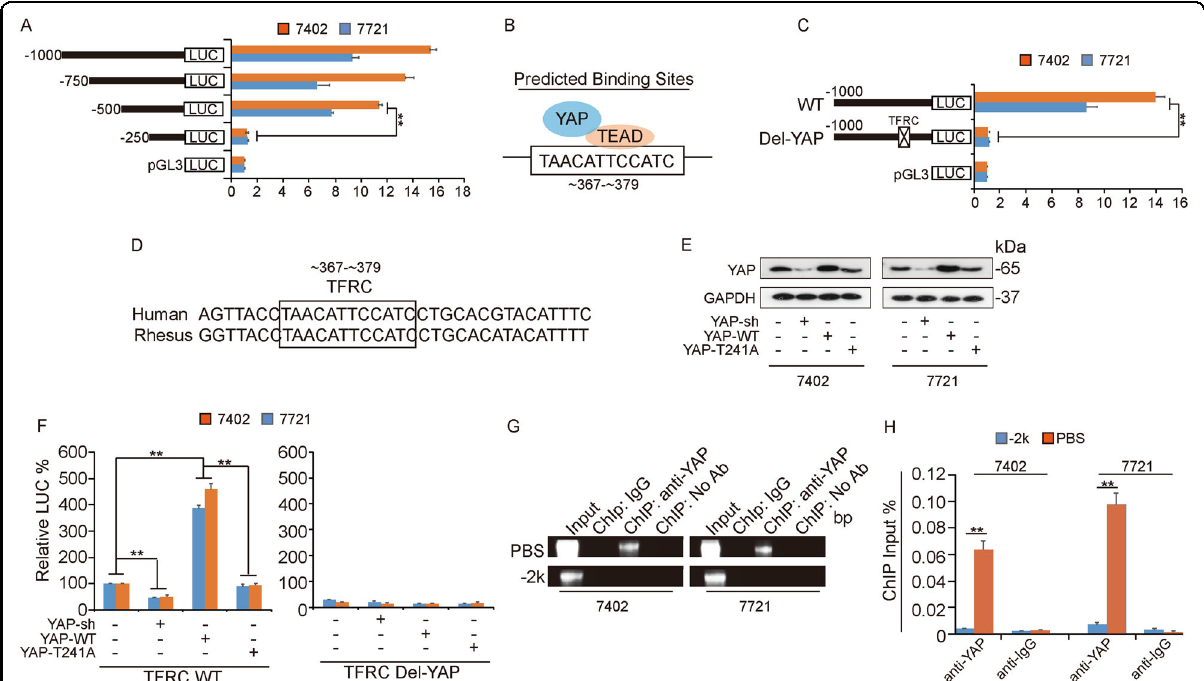
Fig. 5 YAP regulates TFRC expression by binding to its promoter region. A Luciferase activity was measured with a dual-luciferase system using the indicated truncations of the TFRC promoter in Bel-7402 and SMMC-7721 cells. B Predicted binding site (PBS) of TFRC according to bioinformatics analysis. C The PBS was deleted, and the corresponding construct was referred to as Del-YAP. Luciferase activity was measured in Bel-7402 and SMMC-7721 cells. D Regions of PBS are relatively conserved between humans and rhesus macaques. E and F YAP expression was detected by WB ( E ), and TFRC promoter activity was measured with the dual-luciferase system ( F ) in Bel-7402 and SMMC-7721 cells with simultaneous knockdown of YAP and overexpression of YAP-WT or YAP-T241A. G and H Chromatin was immunoprecipitated using an anti-YAP antibody or negative control anti-IgG antibody ( G ), and qPCR (H) was then conducted in Bel-7402 and SMMC-7721